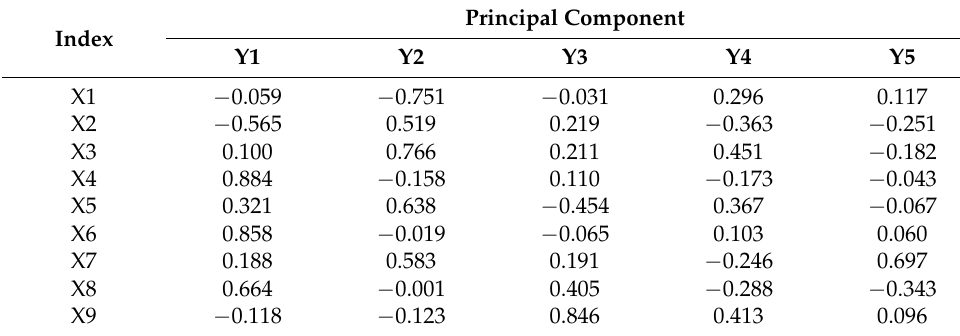
Table 4. Load matrix of the principal component factors.